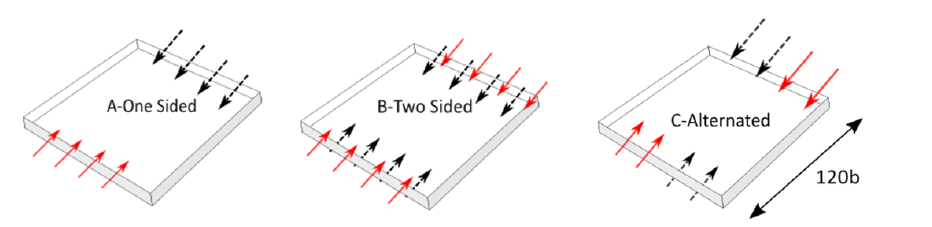
Figure 2. Representation of different cooling schemes in a top view. Red/black arrows indicate that the wall jet is injected above/below the